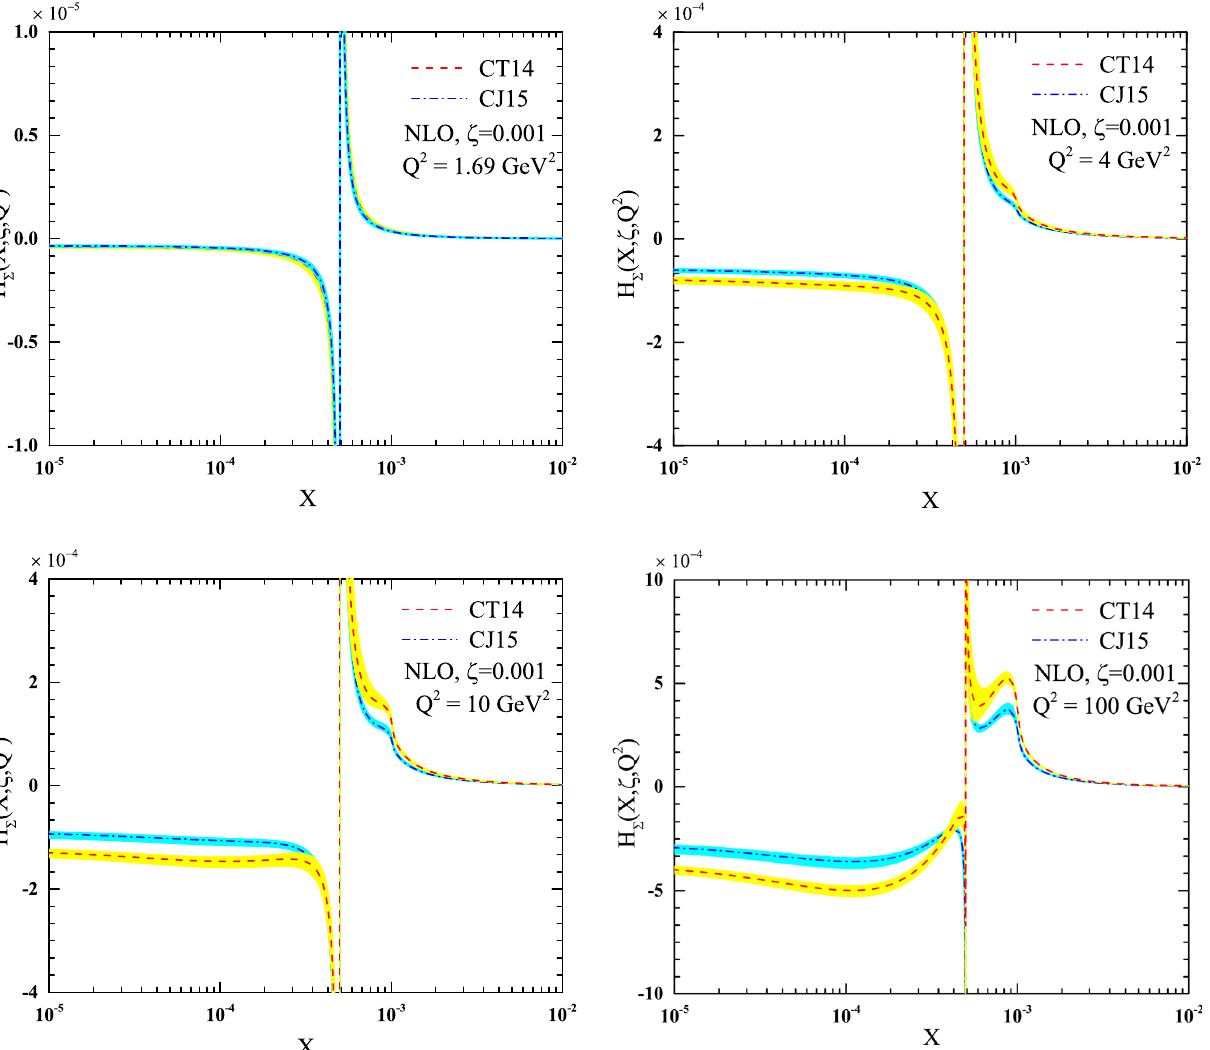
Fig. 1 The singlet quark GPD H S ( X ,ζ, t = 0 , Q 2 ) as a function of X at ζ = 0 . 001 and Q 2 = 1 . 69, 4, 10 and 100 GeV 2 . The GPDs are calculated using the input of Eq. (1) with the CT14 [67] and CJ15 [68] parameterizations of PDFs and NLO Q 2 evolution for